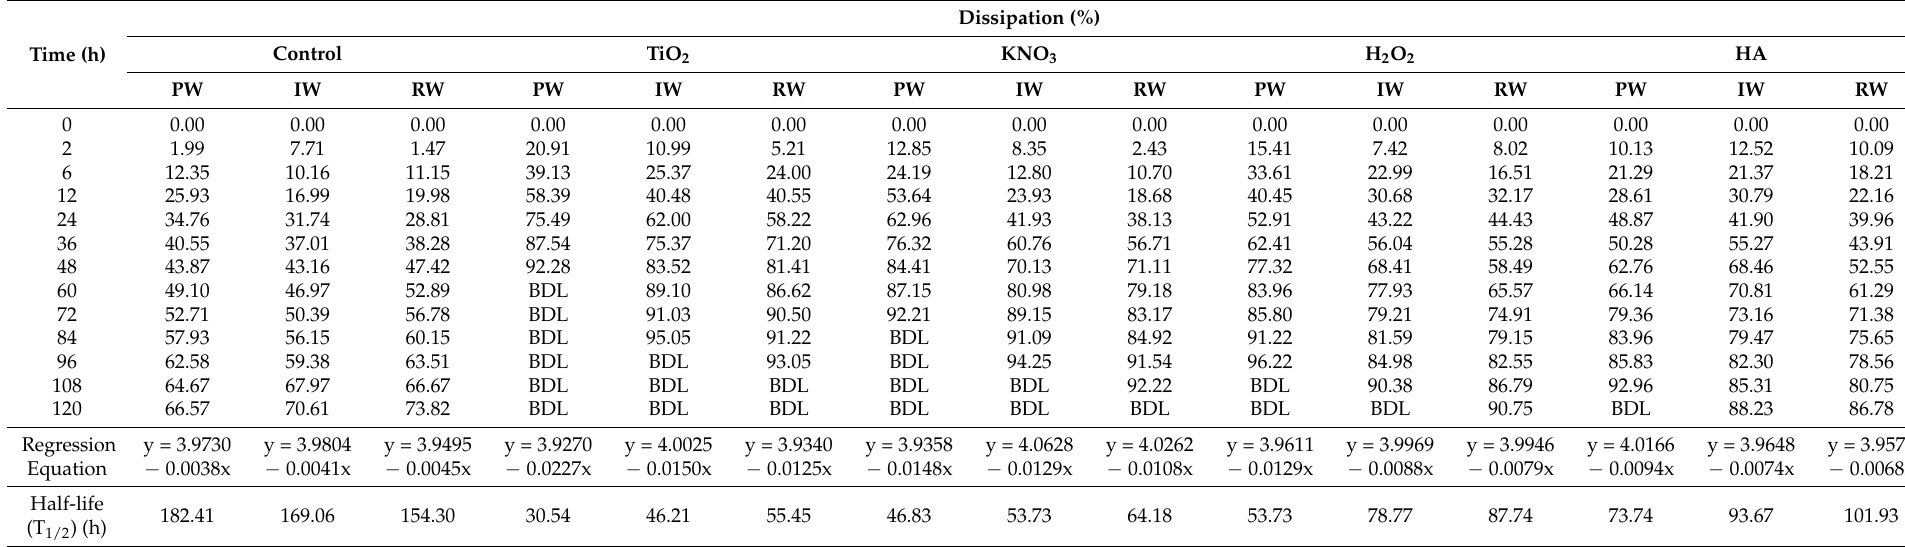
Table 4. Dissipation of flucetosulfuron in water under UV